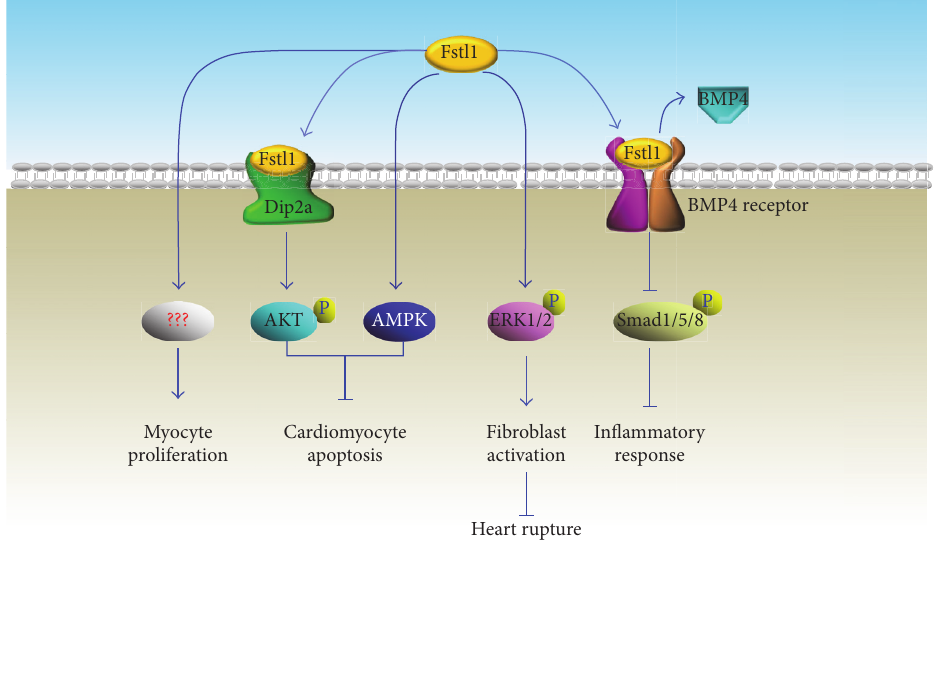
Figure 3: Fstl1-induced effects on cardiac regeneration and